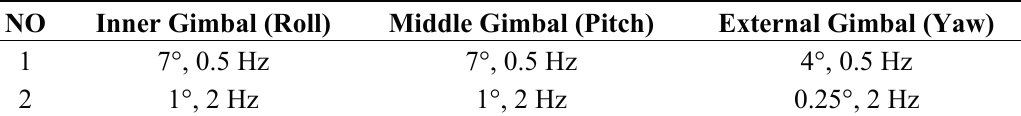
Table 5. DAMS three-axis wobbling test